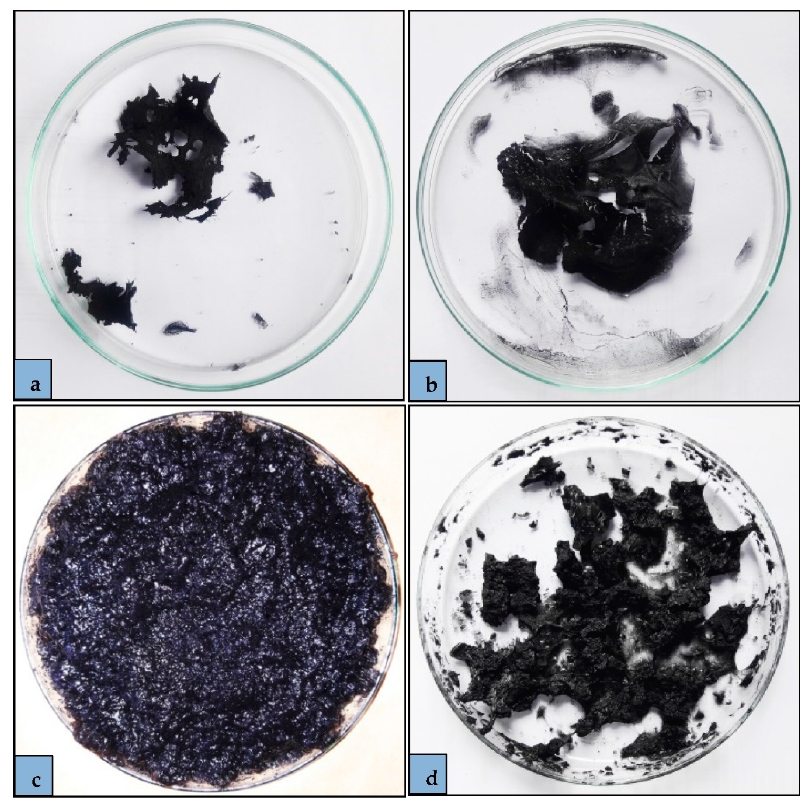
Figure 2. Composite SAP-AC ( a ) 2 wt% and ( b ) 5 wt% by solution mixing and ( c ) freshly prepared SAP-AC (2 wt%) and ( d ) dried SAP-AC by infiltration